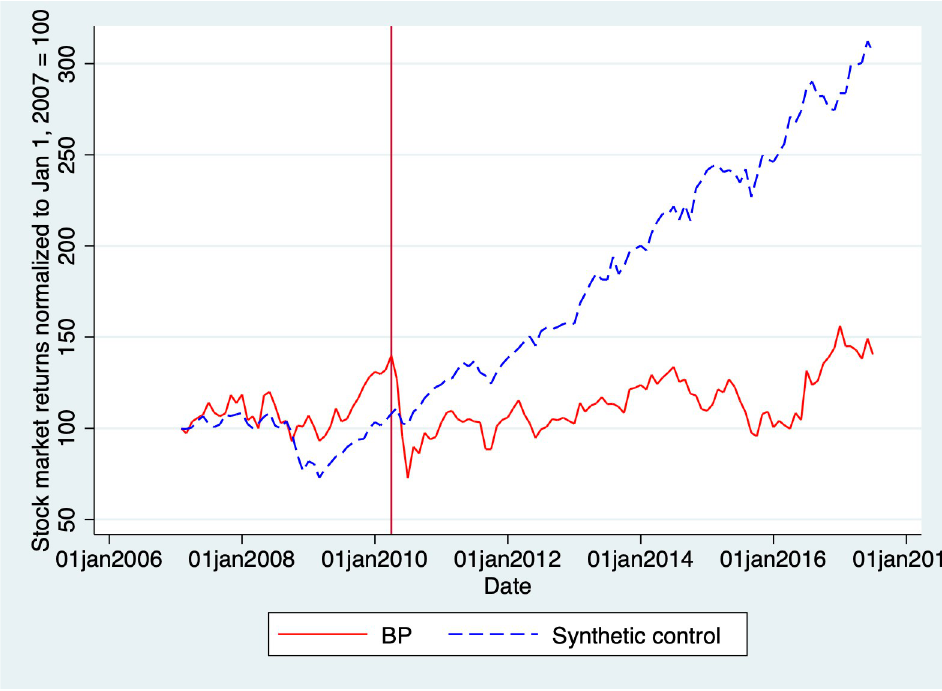
Fig 5. Total Returns of BP vs. synthetic control. Note: In S1 Appendix, we have added the figure with the synthetic control without oil and gas companies. There is a necessary tradeoff here; restricting the set of possible components for